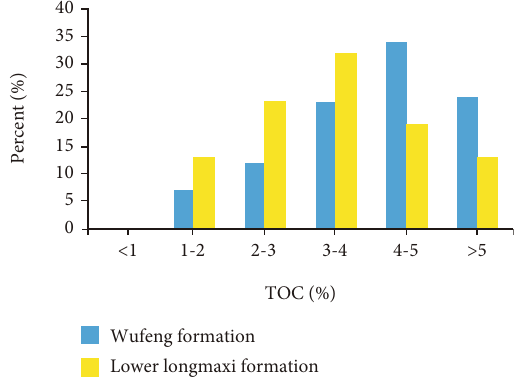
Figure 3: TOC distribution of the shale in the Wufeng-Longmaxi Formation at the southeast Sichuan Basin.